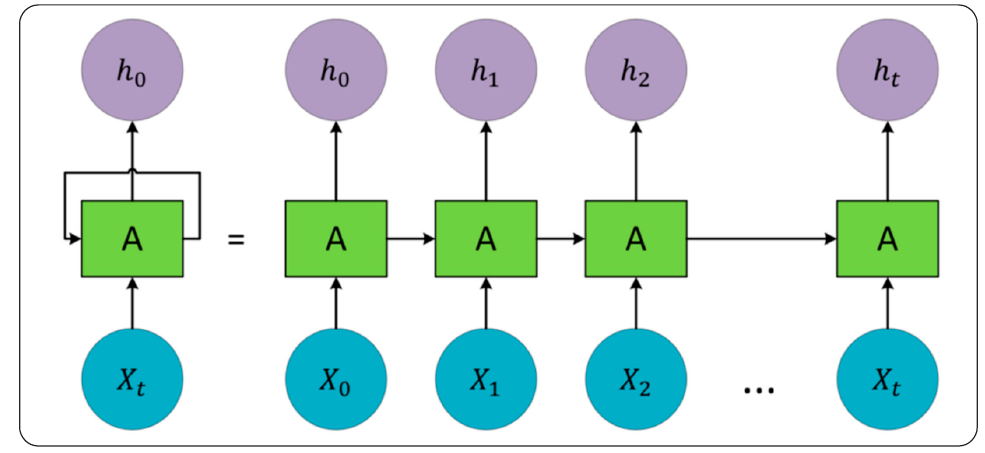
Figure 2. Sequential processing of recurrent neural network [38].